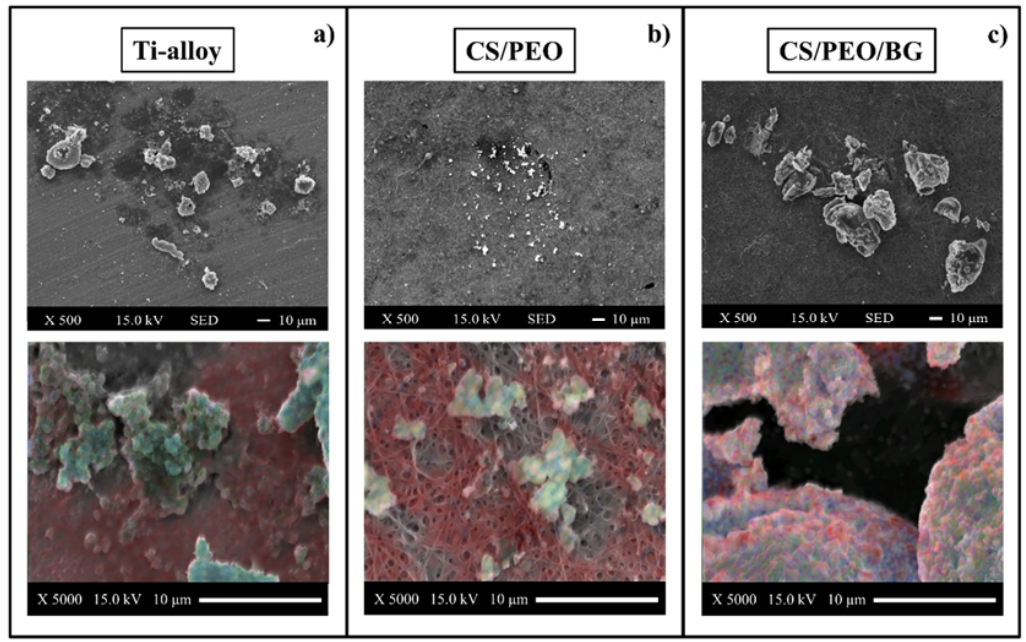
Figure 12. SEM images of bone formation on the three substrates and EDX elemental maps labeled calcium (blue), carbon (red) and phosphorous (blue) to identify the presence of the mineral. SEM images were collected at 500X (Ti ‐ alloy (a), CS/PEO (b), CS/PEO/BG (c)), while EDX maps and related SEM images were collected at 5000X.